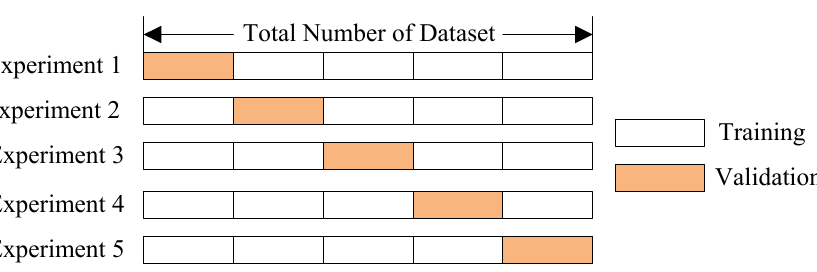
Figure 6. A 5-fold cross validation.